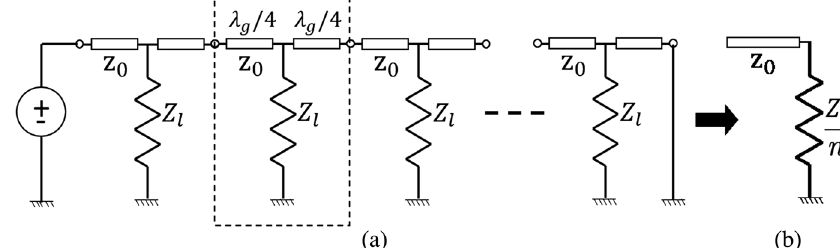
FIG. 2. (a) The isolated manifold system can be viewed as a transmission line with periodic loading with identical loads that has an impedance Z located at i λ g= 2 ; where i ∈ Z (b) the total load impedance can be shown with the help of elementary transmission line l =n theory to be Z l